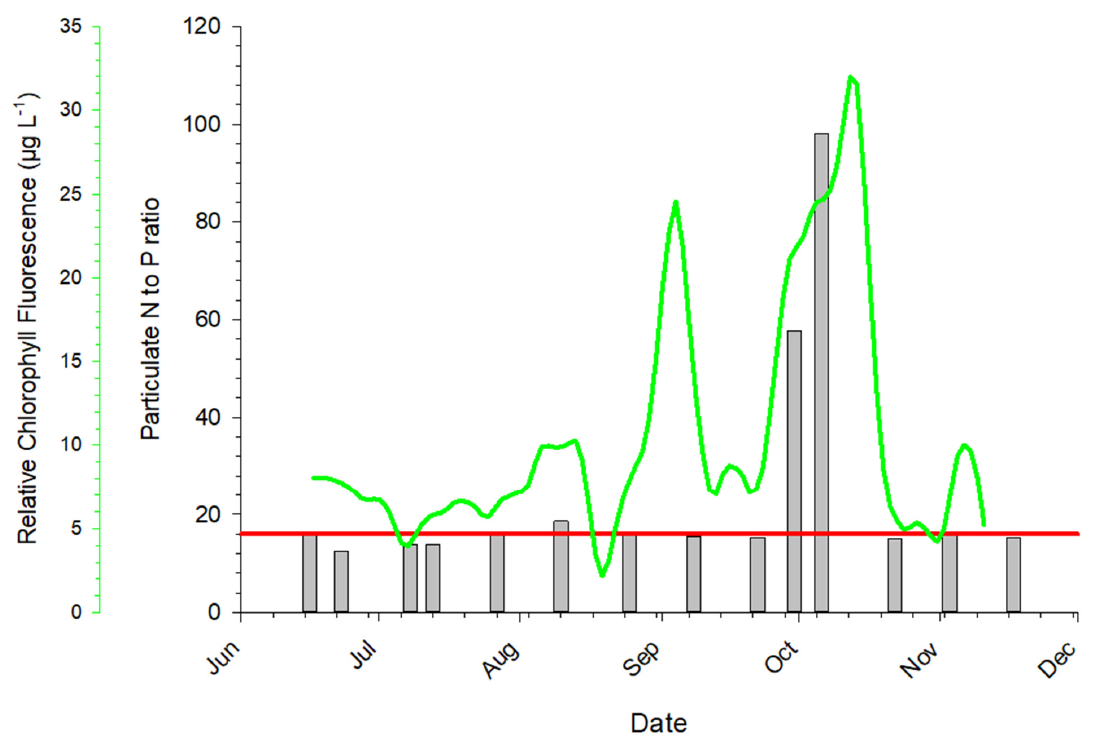
Figure 8. Chlorophyll-a data from the MARVIN deployment with associated particulate N:P ratio. The red line indicates the Redfield Ratio value of 16.